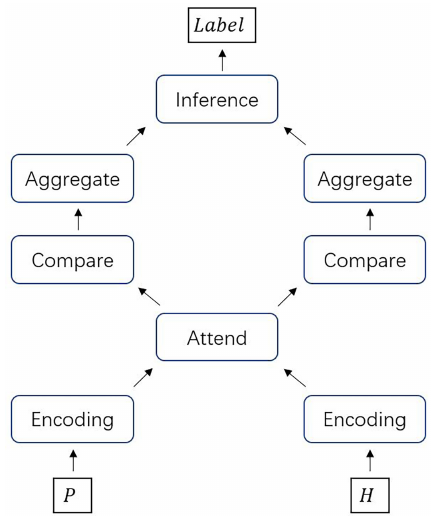
Figure 6. The “matching-aggregation”